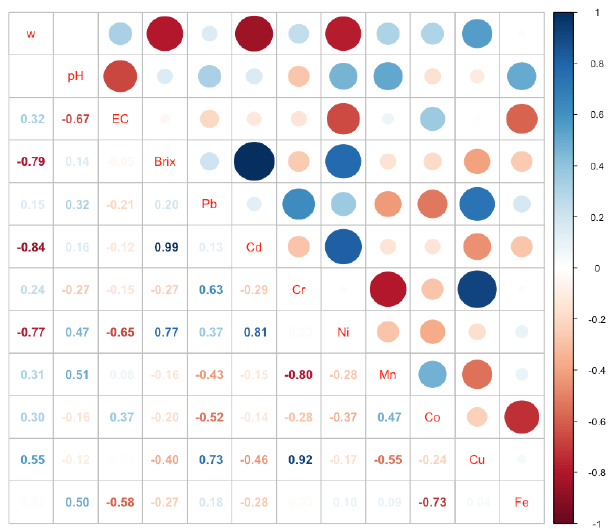
Figure 1. Correlation coefficient matrix for various parameters of honey samples .